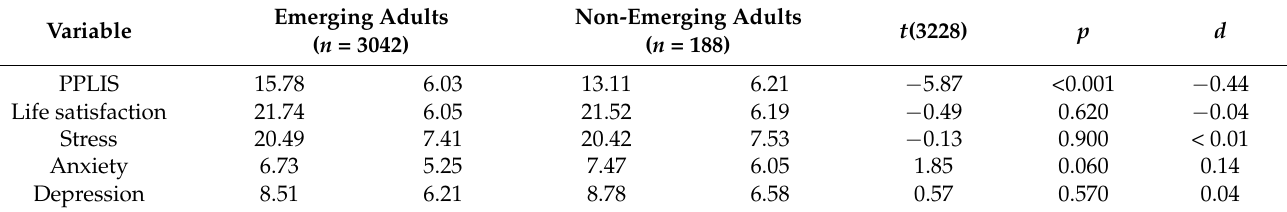
Table 3. Student’s t -test for differences between emerging and non-emerging adults ( N = 3230).